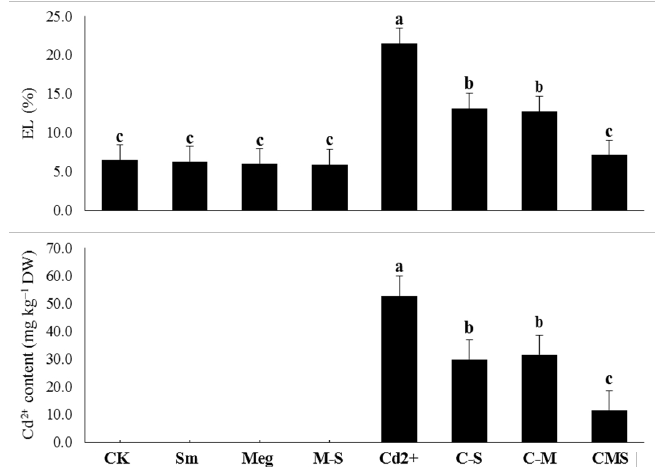
Figure 2. Response of oxidative stress markers (superoxide (O2 •− ) and hydrogen peroxide (H2O2) levels) and their damage (lipid peroxidation as malondialdehyde (MDA) level and ionic leakage (EL, %)) and Cd content of maize plants to foliar application of silymarin (Sm), maize grain extract (MEg), or silymarin-enriched maize grain extract (MEg-Sm) under Cd stress. The same letters on the bars (mean ± SE) of the parameters indicate nonsignificant differences, whereas the significant differences are a result of different letters according to the least significant difference (LSD) test ( P ≤ 0.05). ( P ≤ 0.05). CK = control, Sm = silymarin, Meg = maize grain extract, M-S = silymarin-enriched maize grain extract, C-S = Cd+Sm, C-M = Cd+Meg, CMS =